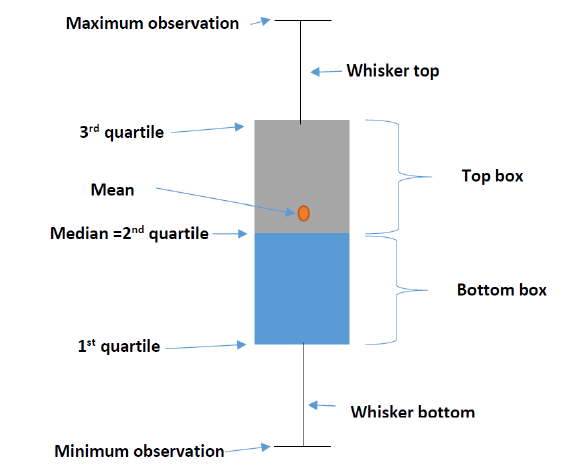
Figure 4. Schematic of